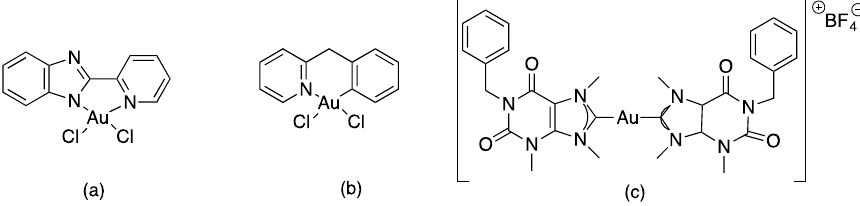
Figure 10. Structure of Au(I) and Au(III) complexes tested in biological activity against Leishaminia sp; ( a ) Au(III) complex; ( b )Au(III) complex; ( c ) Cationic Au(I) bis-N-heterocyclic carbenes.